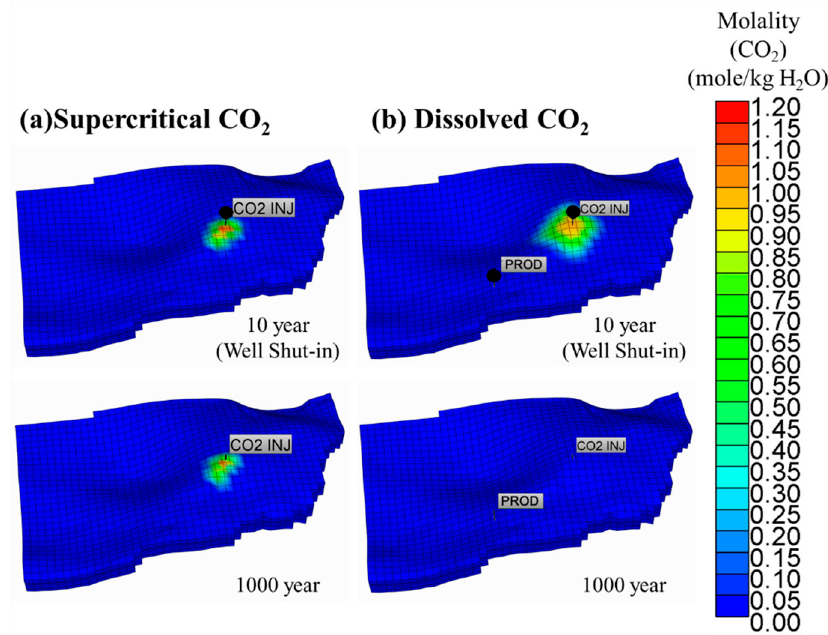
Figure 14. Comparison of the spatial distribution of CO 2 molality between scenarios.